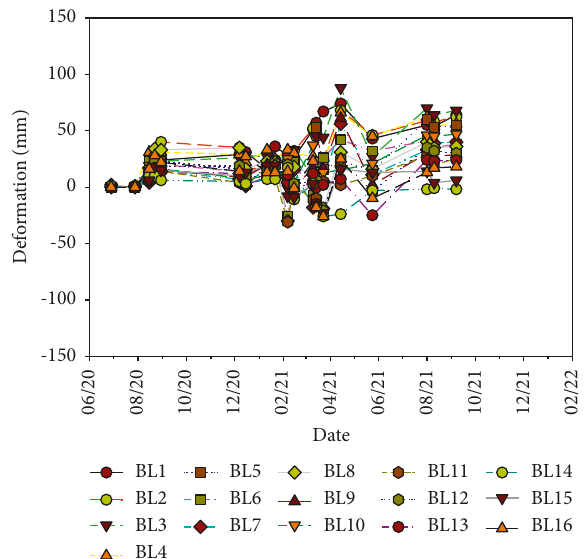
Figure 20: A time series of the change in deformation along the left abutment.